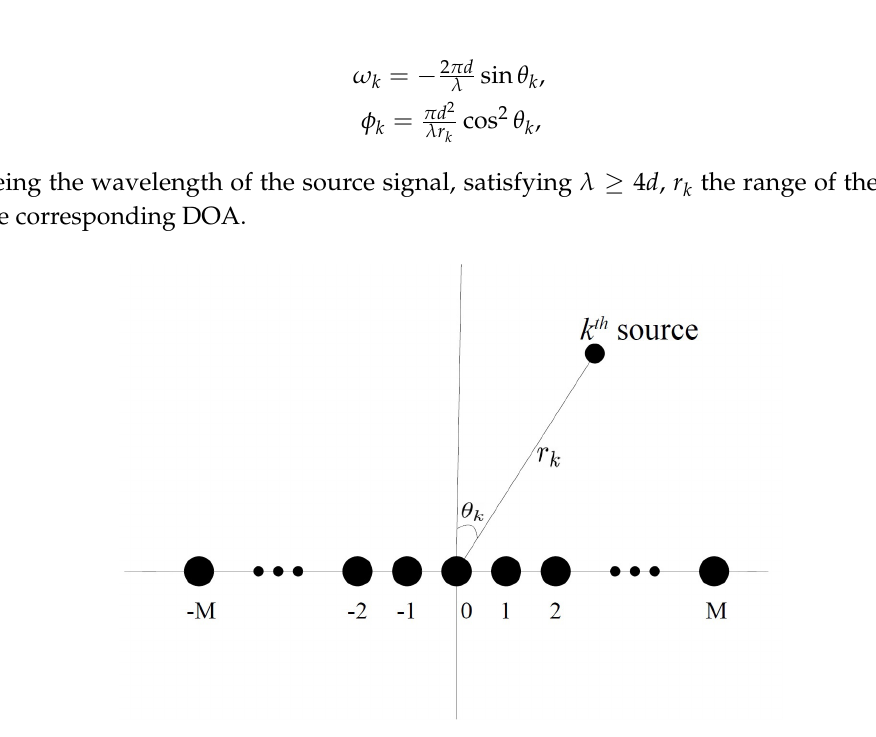
Figure 1. Near-field source localization with